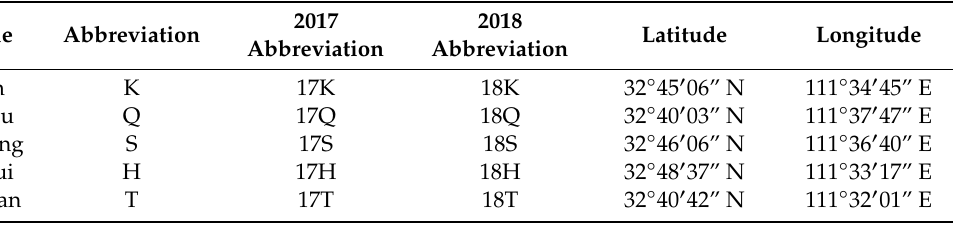
Table 1. Sample number and distribution information.